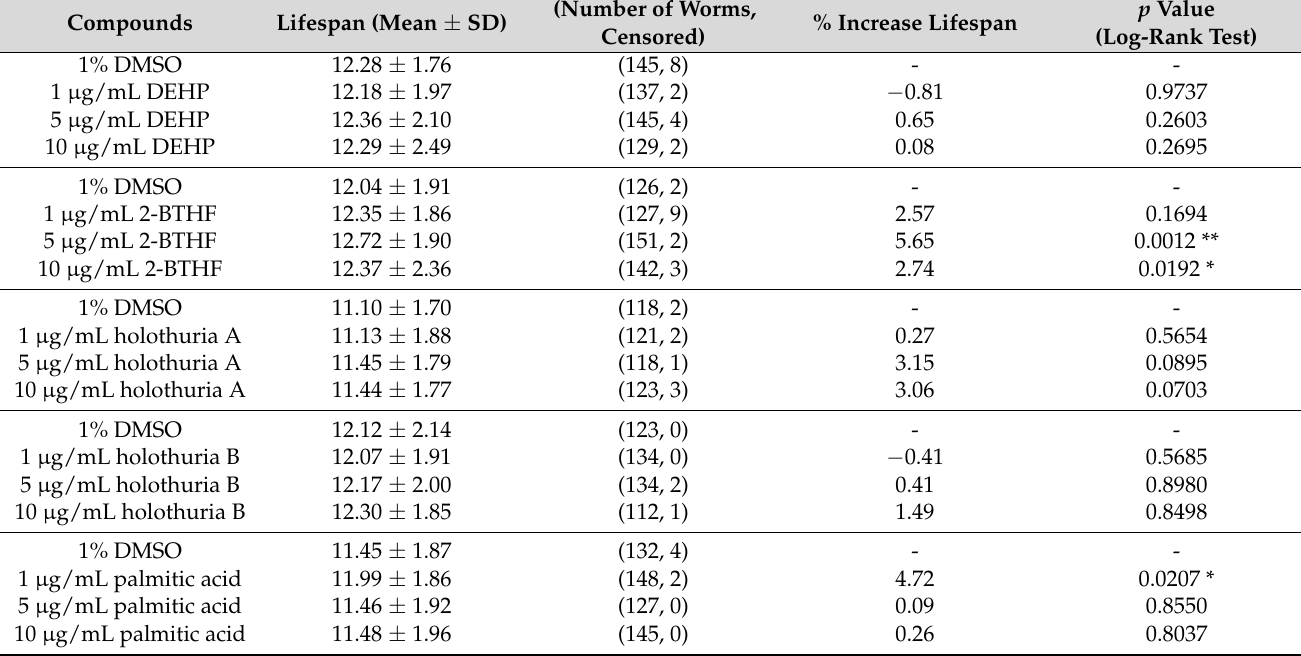
Table 1. Effects of purified H. scabra compounds on mean lifespans of wildtype N2 worms at 25 ◦ C.